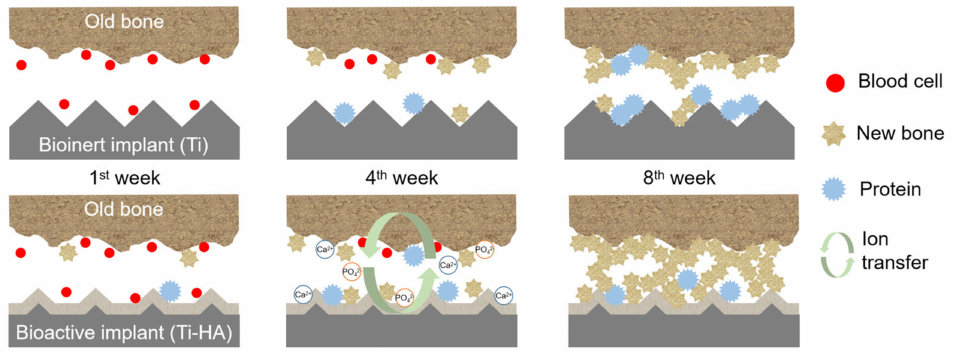
Figure 1. Schematic representation of implant osseointegration for bioinert and bioactive